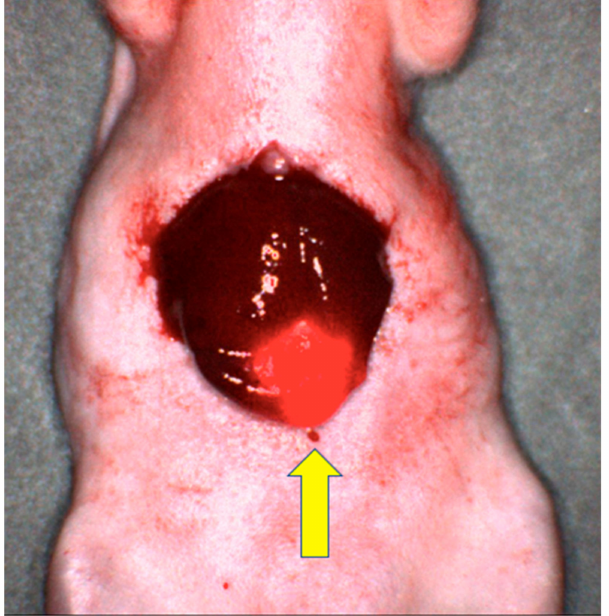
Figure 2. Image of LS174T liver metastasis in a mouse model after labeling with SGM-101. The yellow arrow points to the brightly labeled tumor with surrounding normal liver tissue